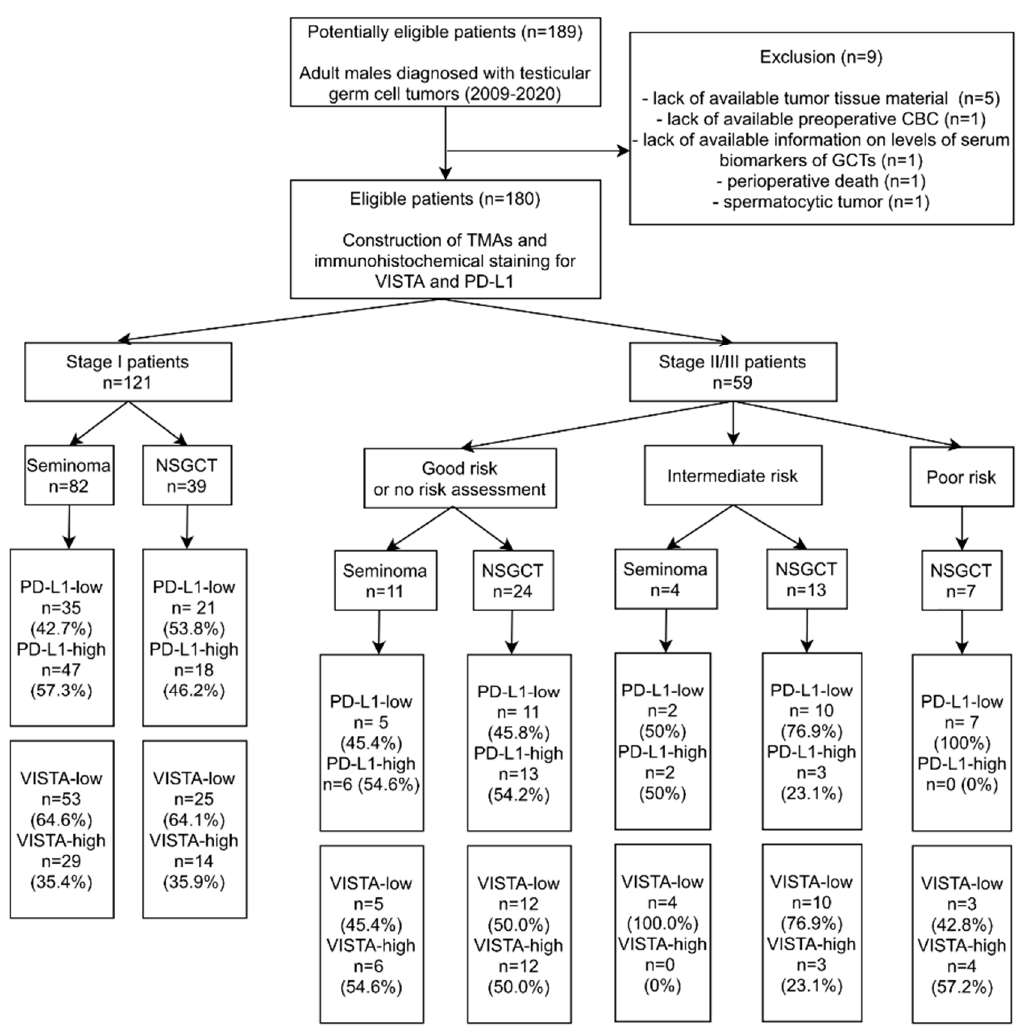
Figure 1. Flow chart with the patients included in the study. Abbreviations: CBC—complete blood count; GCTs—germ cell tumors; NSGCT—nonseminomatous germ cell tumor; TMAs—tissue microarrays; PD-L1—Programmed death-ligand 1; VISTA—V-domain immunoglobulin suppressor of T cell activation.